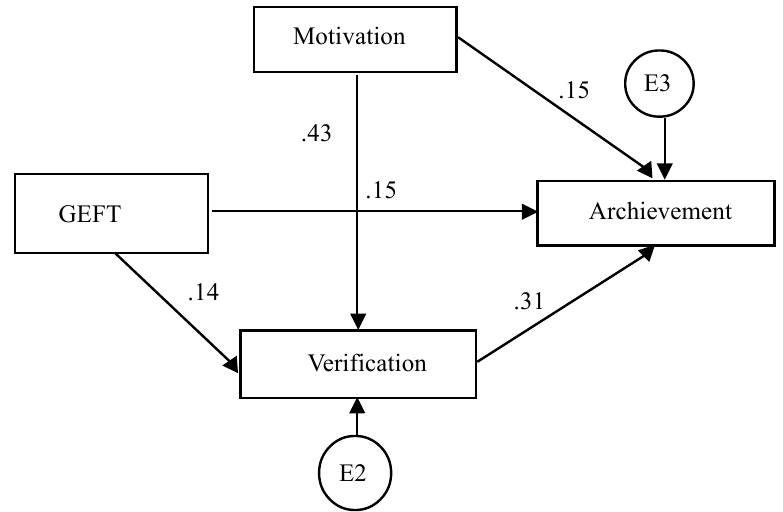
Figure 1. Standardized estimates corresponding to the explanatory model of academic achievement.